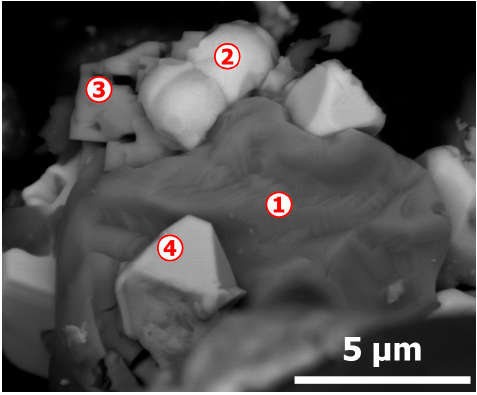
Figure 8. SEM aspects (backscattered electron micrograph) of the CAS sample treated at 770 ◦ C in air. Table 2. Elemental composition (EDS data) of the CAS treated at 770 ◦ C in air atmosphere. Elements